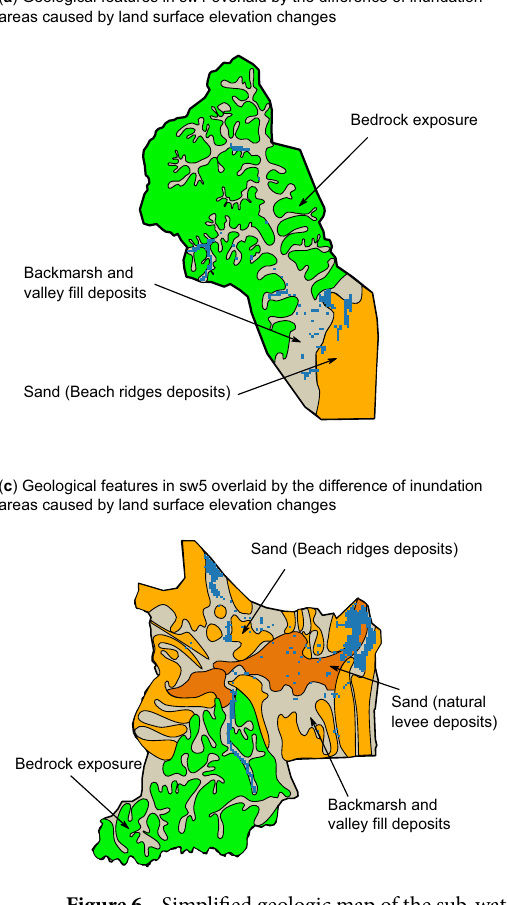
Figure 6. Simplified geologic map of the sub-watersheds ( a ) sw1, ( b ) sw3, and ( c ) sw5, overlaid by the difference of inundation areas during typhoon Wipha in the year 2013. (Figure generated using Matplotlib